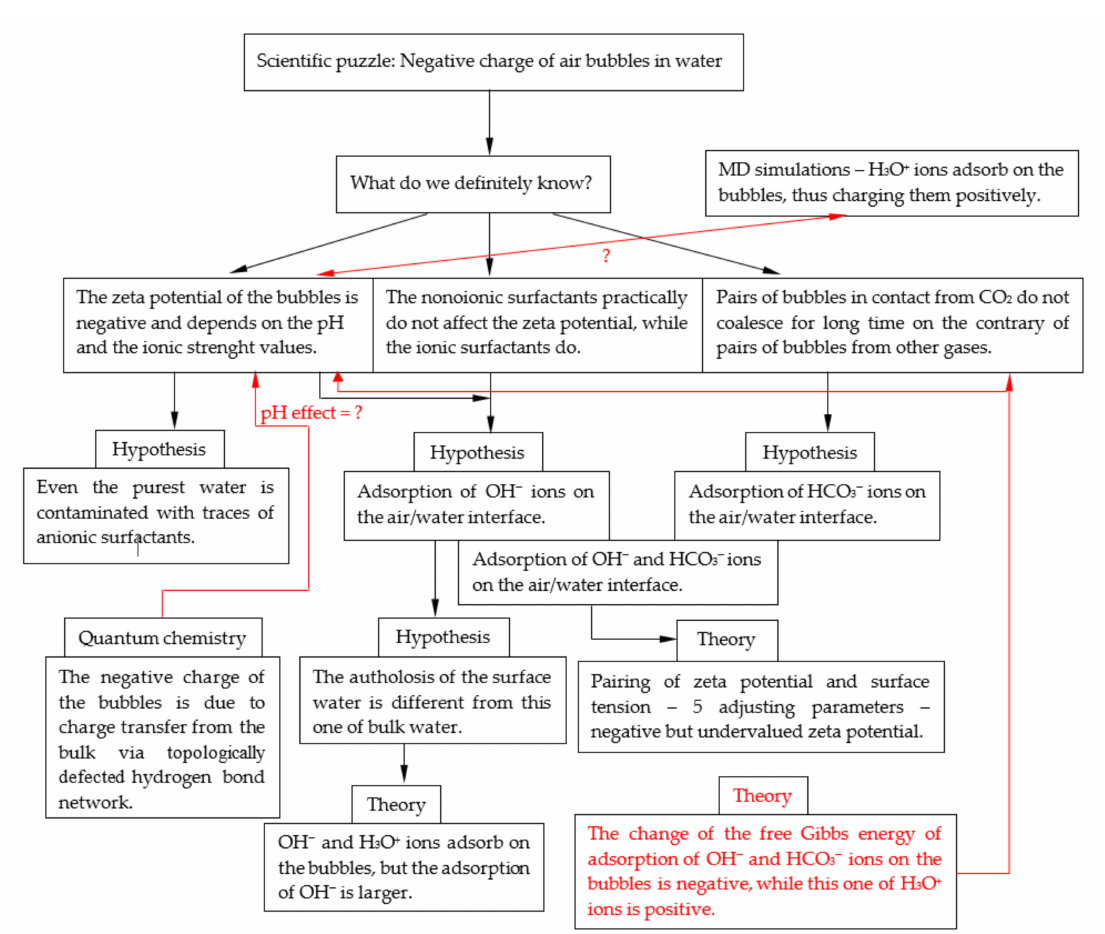
Figure 5. A scheme of the basic experimental findings and the available explanations of the origin of the negative charge of the